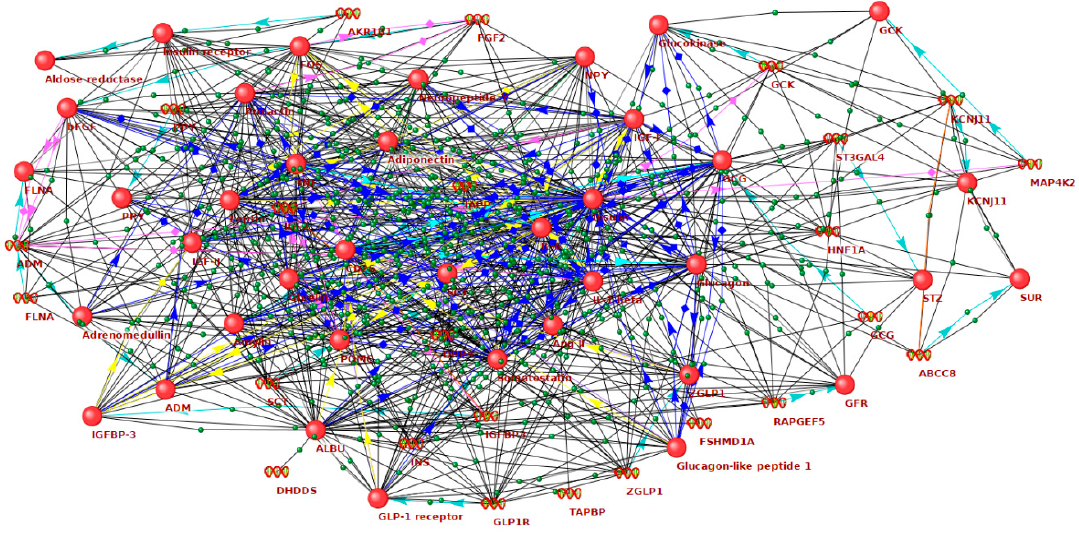
Figure 1. A network of the interactions of genes and proteins associated with both hyperglycemia and hypoglycemia (glucose variability (GV))-related genes), reconstructed by the ANDSystem. Ten GV-related genes showed the largest number of connections with other molecules in the network (Table 1). Among these molecules, as expected, there are insulin ( INS ) and glucagon ( GCG ), two principal regulators of blood glucose level in humans, as well as other hormones that affect glucose metabolism directly or indirectly, including leptin ( LEP ), insulin-like growth factor 1 ( IGF1 ), somatostatin ( SST ), adiponectin ( ADIPOQ ), prolactin ( PRL ), ghrelin ( GHRL ), glucagon like peptide 1 receptor ( GLP1R ), proopiomelanocortin ( POMC ), amylin ( IAPP ), adrenomedullin ( ADM ), angiotensin II ( AGT ), secretin ( SCT ), and pancreatic polypeptide ( PPY ). The network includes genes encoding proinflammatory cytokines ( IL6, IL1B, TNF ), growth factors ( FGF2, IGF2 ), molecules involved in the orchestration of insulin secretion and signaling ( GCK, KCNJ11, ABCC8, INSR, FLNA ), transcriptional factors ( HNF1A, FOS, ZGLP1 ), neurotransmitter ( NPY ), enzymes ( DPP4, AKR1B1, ST3GAL4, MAP4K2, RAPGEF5 ), and binding proteins (ALB, IGFBP3, TAPBP). Table 1. The genes demonstrating the largest number of connections in the gene network of hypoglycemia and hyperglycemia. Gene Symbol Gene Product Number of Connections